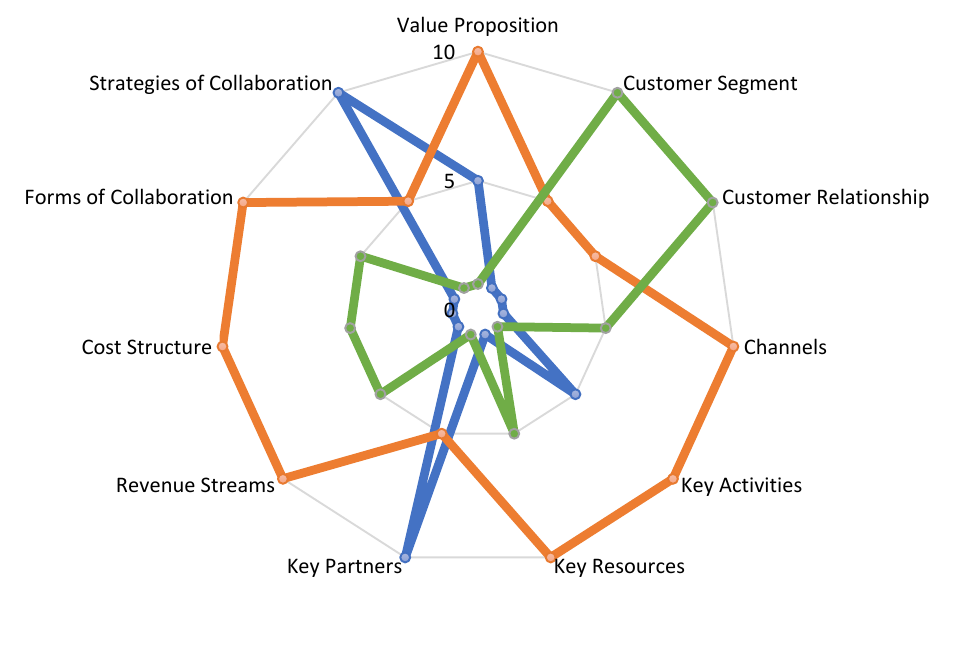
Figure 8. Collaborative business model comparison in the freight Figure 8 . Collaborative business model comparison in the freight industry.